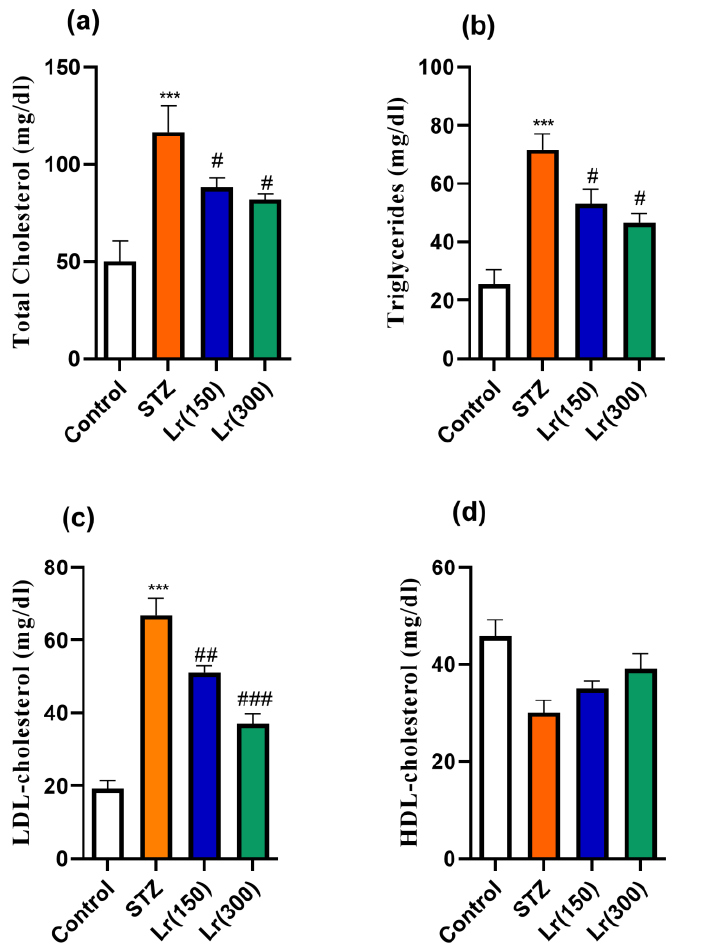
Figure 2. Effect of L. regularis (150 or 300 mg/kg for 4 consecutive weeks) on diabetic-induced changes in serum total cholesterol ( a ), triglycerides ( b ), low density lipoprotein cholesterol (LDL-cholesterol) ( c ) and high-density lipoprotein cholesterol (HDL-cholesterol levels) ( d ). Data are expressed as means ± SE ( n = 6) and were analyzed using one-way ANOVA followed by Student Newman–Keuls as post hoc test. * Control vs. STZ group; # STZ vs. L. regularis (150) or L. regularis (300). # p < 0.05, ## p < 0.01, *** or ### p <